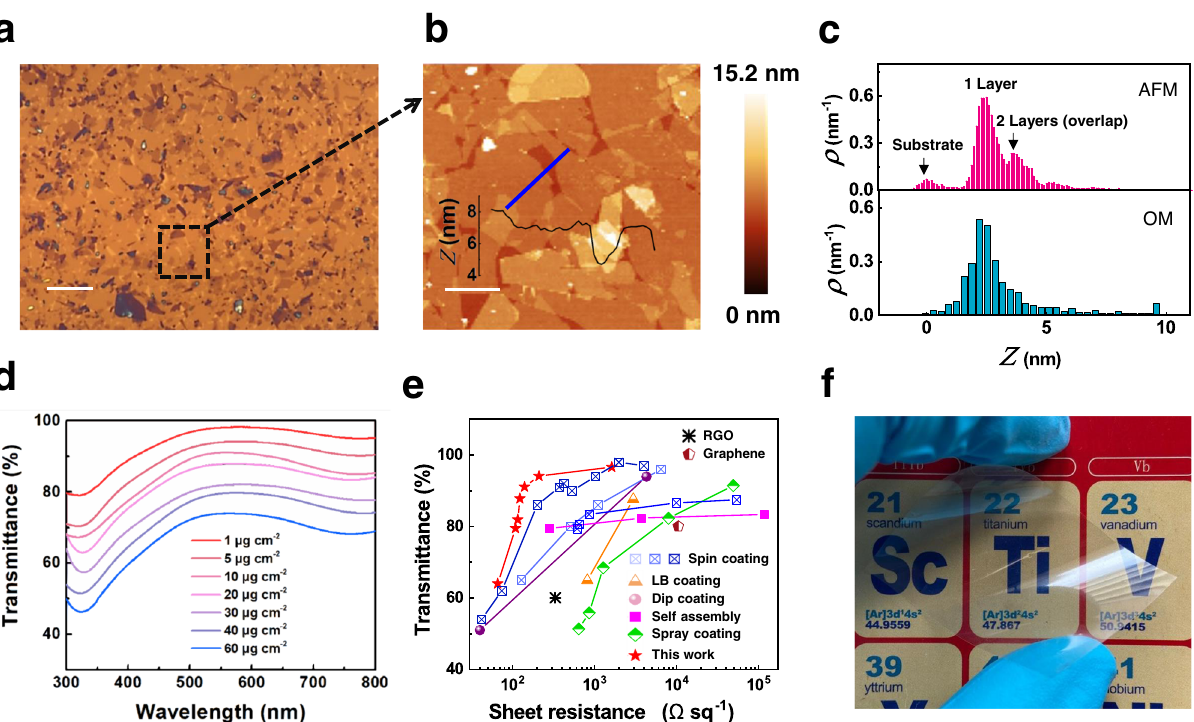
Fig. 3 Characterization of the self-assembled Ti 3 C 2 T x thin fi lm as a transparent electrode. a OM image of the assembled Ti 3 C 2 T x thin fi lm (scale bar: 10 μ m); b AFM image and the height pro fi le of the assembled Ti fi lm in corresponding area marked in a (scale bar: 2 μ m). c Thickness distributions 3 C 2 T x thin extracted from the AFM image (top) and the OM image (bottom); the Y -axes are probability density, namely, frequency per unit height; d Transmittance spectra of Ti 3 C 2 T x fi lms with various concentrations of injected Ti 3 C 2 T x ; e Transmittance at 550 nm as a function of sheet resistance for the Ti 3 C 2 T x fi lms and data from previously reported transparent electrode technologies; RGO reduced graphene oxide, LB Langmuir – Blodgett. f Photograph of a Ti 3 C 2 Tx fi lm deposited on a PET substrate that presents excellent transparency and fl resistance measurement technique. The UV-vis spectra of these fi lms with different Ti 3 C 2 T x area concentrations are presented in Fig. 3d, where the area concentration is de fi ned as the mass of Ti 3 C 2 T x per square centimeter, and tuned by the volume of 2 mg/ml Ti 3 C 2 T x dispersion injected at the interface during the assembly. The transmittance of LLIA Ti 3 C 2 T x at 550 nm reaches 96.8% when the area concentration is 1 µg cm − 2 , and decreases steadily to 64.3% as the area concentration increases to 60 µg cm − 2 32 . The transmittance at 550 nm versus the sheet resistance ( R s ) of the LLIA fi lms, together with the data from previously reported techniques, are plotted in Fig. 3e. The R s value of the LLIA Ti 3 C 2 T x fi lm reaches 1623 Ω sq − 1 at a transmittance of 96.9%, 210 Ω sq − 1 at 94.1%, and 123 Ω sq − 1 at 87.8%. Comparing the resistances of materials with the similar transparency, our values are lower than MXene fi lms made by other methods like spin coating (201 Ω sq − 1 at 87%), dip coating (4300 Ω sq − 1 at 94%), and spray coating (7974 Ω sq − 1 at 82%), and also lower than other transparent conductive materials such as graphene, and reduced graphene oxide (see Supplementary Table 1 for a summary of different transparent conductive materials) 30,31,33 – 40 . Finally, Fig. 3f shows that the LLIA Ti 3 C 2 T x fi lm can be transferred onto a fl exible substrate (e.g., PET) uniformly in a large area (~25 cm 2 ) with excellent optical transparency, suitable for transparent conductive electrodes for the proposed fl exible EC devices.